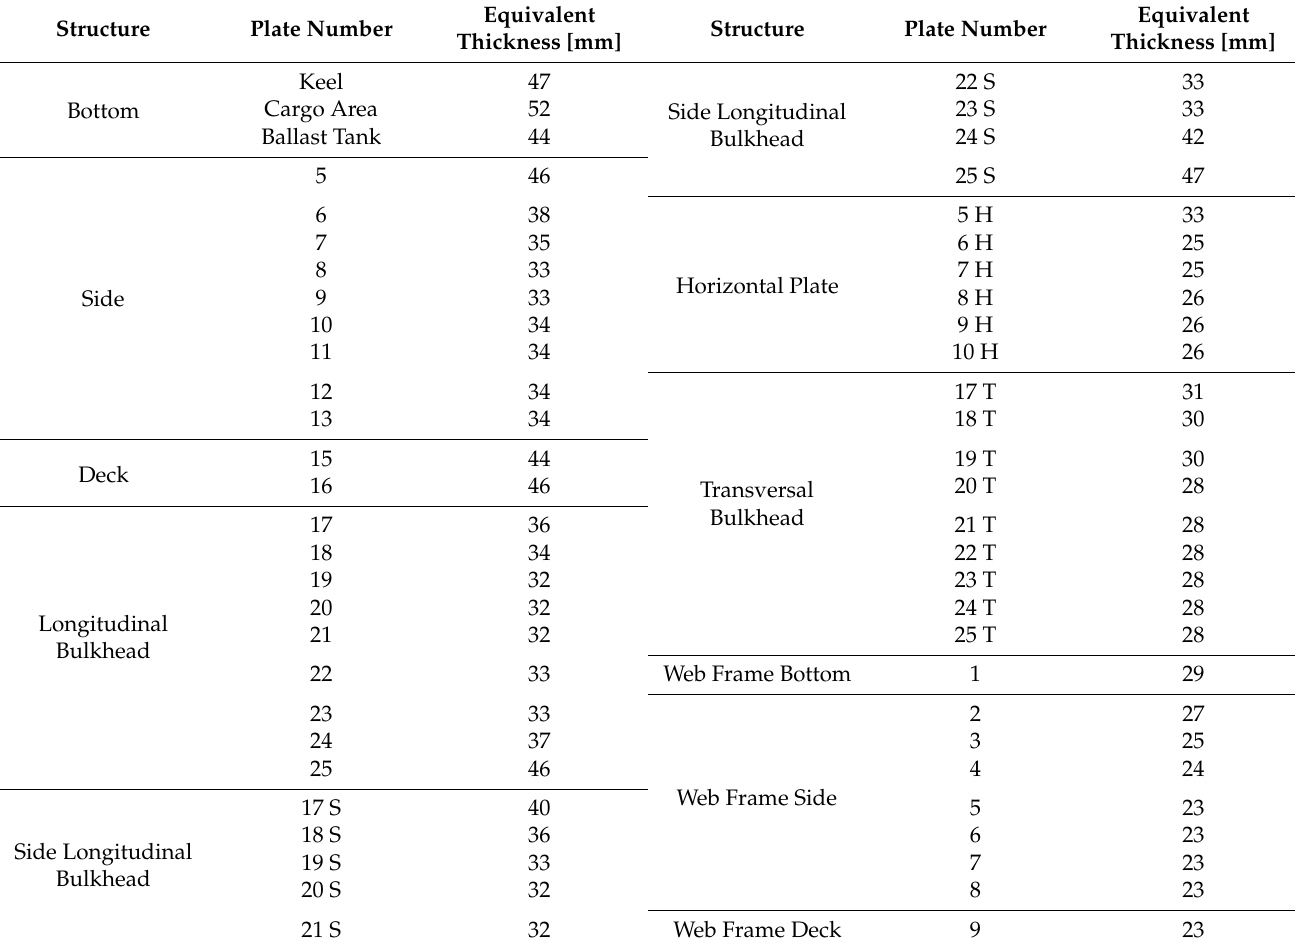
Table 7. Equivalent thickness for the steel